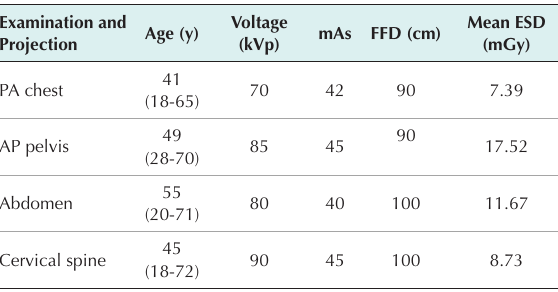
Table 1. Patients ’ Characteristics and Technical Parameters for Selected Examinations in 3 Hospitals